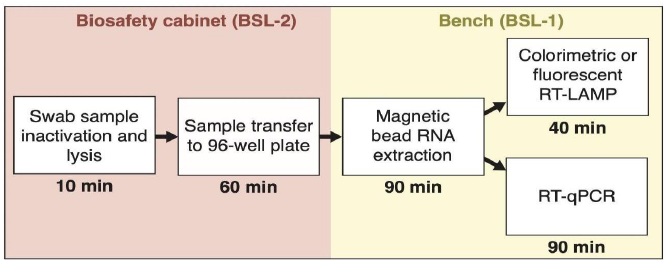
Figure 2. Overview and timeline of sample processing using a magnetic bead RNA purification protocol for SARS-CoV-2 diagnostics. 3.1. RNA Extraction Using Magnetic Beads Yields RT-qPCR Results That Are Comparable to a Commercial Extraction Kit We first applied both protocols on one SARS-CoV-2 positive pharyngeal swab sample, which was diluted in RNase-free water prior to RNA isolation in a 10-fold dilution series up to 10 5 fold, in order to compare the magnetic bead RNA extraction protocol with the commercial QIAcube extraction method. The extracted RNA was subjected to RT-qPCR using E gene primers. Viral RNA was detected in samples diluted up to 10 5 fold after either QIAcube or magnetic bead RNA extraction (Figure 3A,C). RT-qPCR of the extracted RNA by either of the two methods showed approximately equidistant amplification curves with an interval of 4 CT values for each 10-fold dilution step (Figure 3B,D).